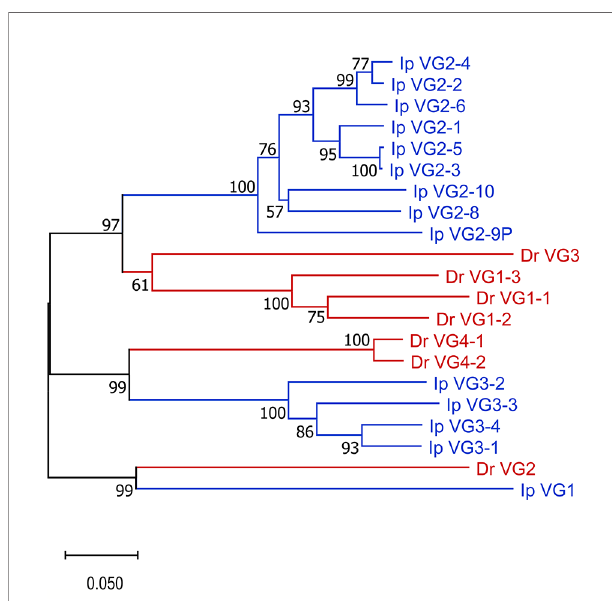
FIGURE 6 | TRGV phylogenic analysis. Cat fi sh TRGV gene subgroups are phylogenetically more closely related to zebra fi sh TRGV subgroups than to each other. The evolutionary history was inferred using the Neighbor-Joining method (47). The percentage of replicate trees in which the associated taxa clustered together in the bootstrap test (10,000 replicates) are shown next to the branches (48). The tree is drawn to scale, with branch lengths in the same units as those of the evolutionary distances used to infer the phylogenetic tree. The evolutionary distances were computed using the p- distance method (49) and are in the units of the number of base differences per site. This analysis involved 21 nucleotide sequences. Prior to analysis, sequences were trimmed to include 22 codons before the codon for the fi rst cysteine (CYS23) to 6 nucleotides past the last cysteine (CYS104). All ambiguous positions were removed for each sequence pair (pairwise deletion option). There were a total of 300 positions in the fi nal dataset, and evolutionary analyses were conducted in MEGA X (40). Species are indicated by color, Danio rerio (red) and Ictalurus punctatus